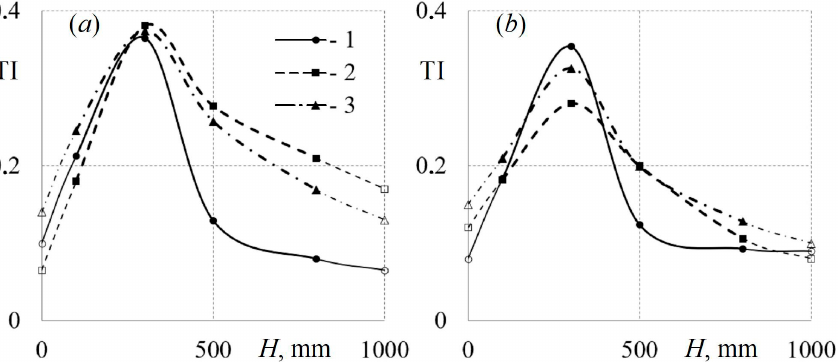
Figure 11. Dependences of the intensity of turbulence TI on the height of the diffuser H when air is supplied through round (1), square (2), and triangular (3) tubes for the initial average flow velocity in the first section: ( a )—w 1 ≈ 6.5 m/s; ( b )—w 1 ≈ 8.25 m/s.